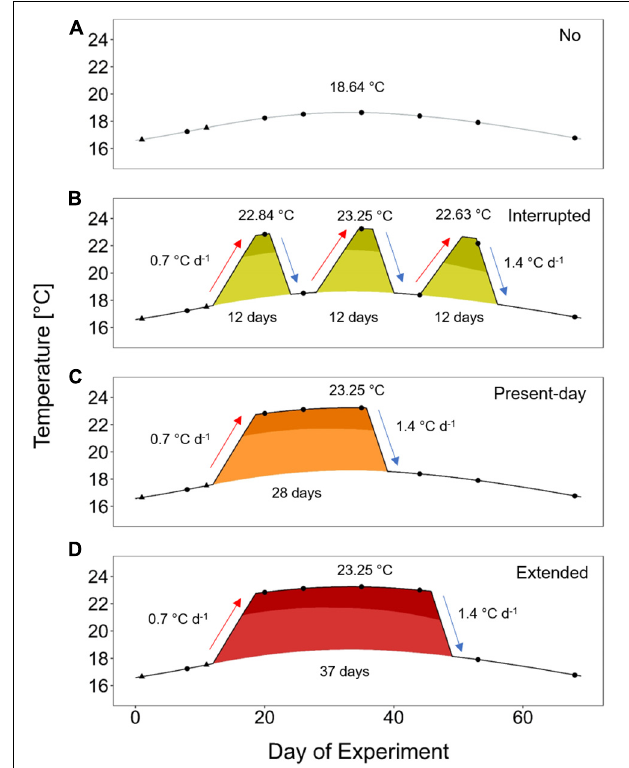
FIGURE 1 | Experimental treatments based on the heatwave definition by Hobday et al. (2016). The treatments followed a smoothed natural summer seasonal temperature profile [ No heatwave, gray line in panel (A) ; “climatological values” in Hobday et al. (2016)] or experienced three short heatwaves of 12 days each [ Interrupted , yellow-green filling in panel (B) ], a heatwave of 28 days [ Present-day , orange filling in panel (C) ] or a heatwave of an extended duration of 37 days [ Extended , red filling in panel (D) ]. Durations refer to the period with temperatures above the climatological values. Temperatures above the 90th percentile are shown in a darker shade. All heatwaves had a maximum peak of +4.6 ◦ C above the climatological values. Mean temperatures of the Interrupted and Present-day heatwave treatments were equal. Black triangles represent measuring points for wet weight of A. rubens , and black dots indicate additional assessments of righting